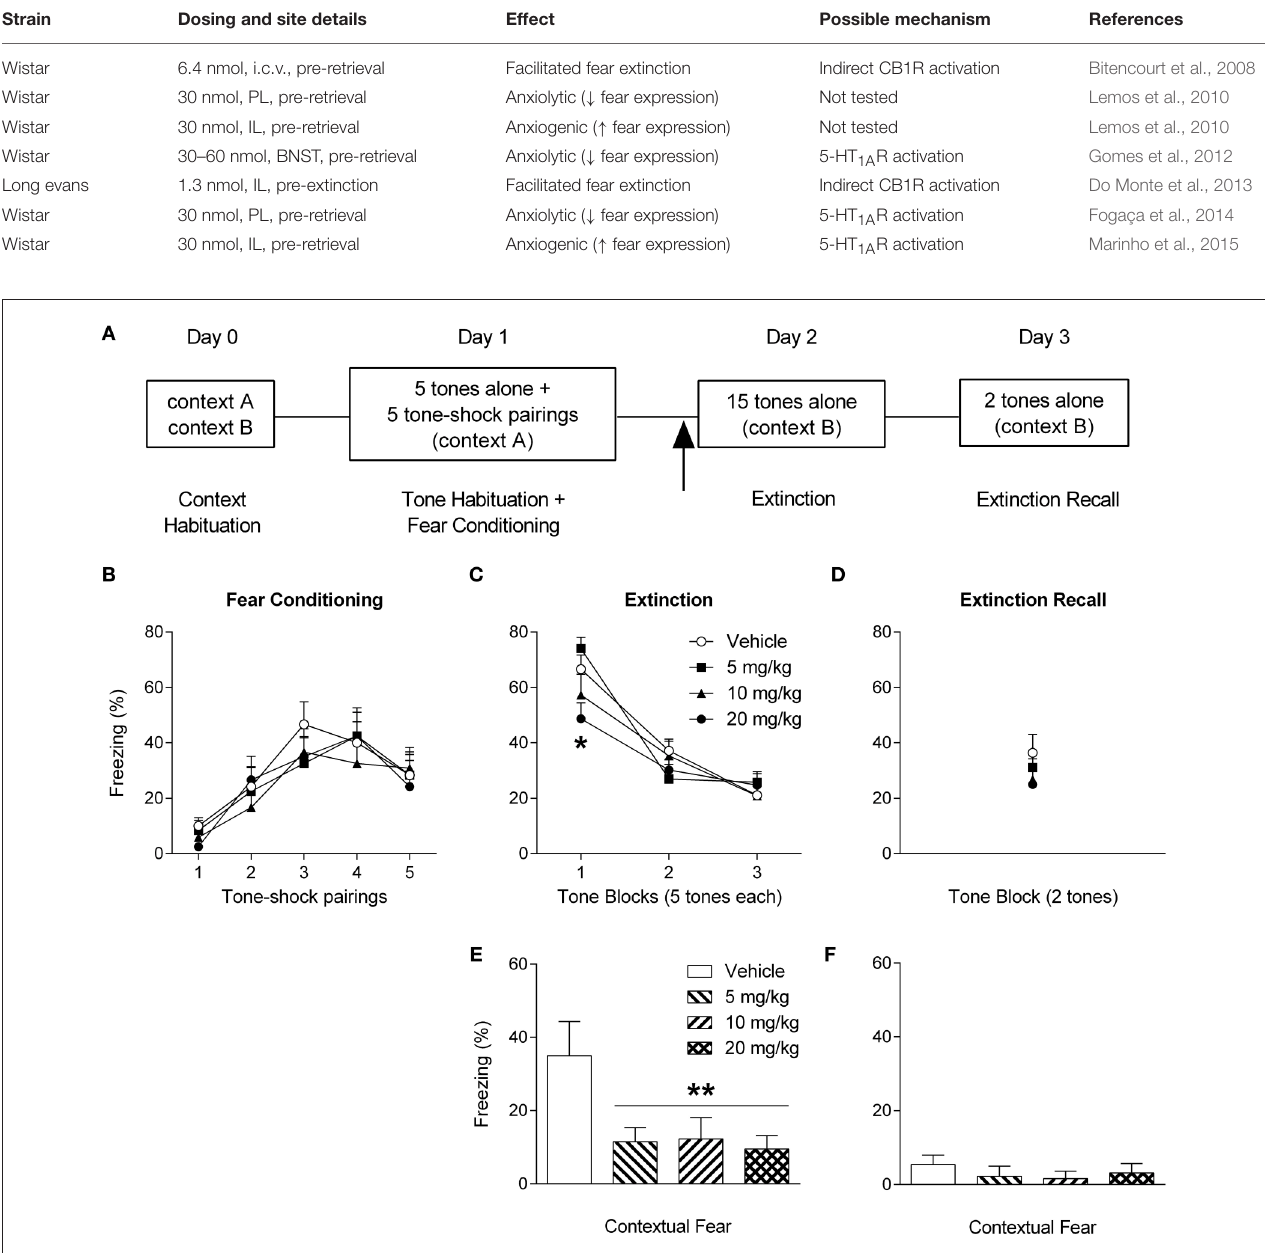
FIGURE 2 | Cannabidiol reduces the expression of auditory and contextual fear memory in rats. (A) Schematic representation of the experimental procedures used; the arrow indicates that drug was injected 30min before extinction. (B) Freezing during tone-shock pairings did not differ between the groups during auditory fear conditioning. (C) Rats treated with 20 mg/kg of cannabidiol showed significantly decreased freezing during tone presentations at the start of extinction, compared to rats given 5 mg/kg or vehicle (* P < 0.05). (D) There were no differences in tone-induced freezing between the groups during extinction recall. (E) Rats treated with 5, 10, or 20mg/kg of cannabidiol showed significantly decreased freezing in the 2 min period before tone presentations during extinction, compared to vehicle-treated controls (** P < 0.01). (F) There were no differences in freezing between the groups in the 2 min period before tone presentations during extinction recall (see Supplementary Material for more